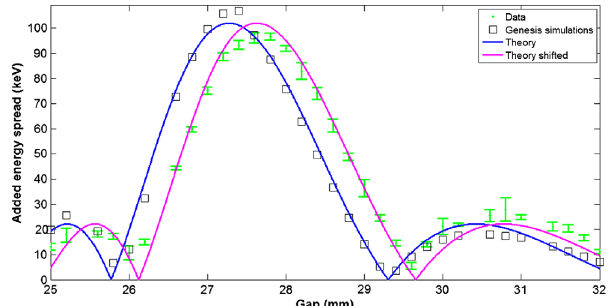
FIG. 5. Electron beam slice energy spread added by the LH vs undulator gap: theoretical (solid lines) and experimental (green dots). The black squares are simulation results from the GENESIS1.3 simulation code.